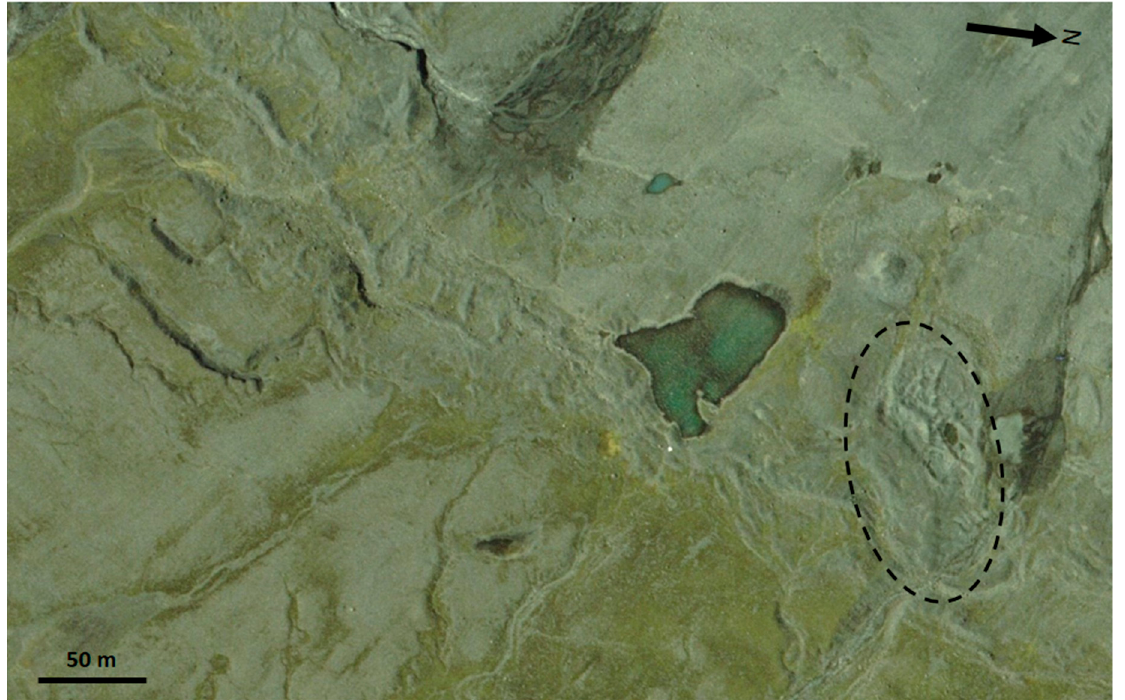
Figure 11. Aerial photograph extract (NERC ARSF 2007) of the 1980s-1990s moraine belt on the Oldufellsjökull foreland (compare with Figure 4 to see the evolution of the landforms since the 1990s). The supraglacial infill of a crevasse-controlled re-entrant, created between 1984 and 1994, is circled.